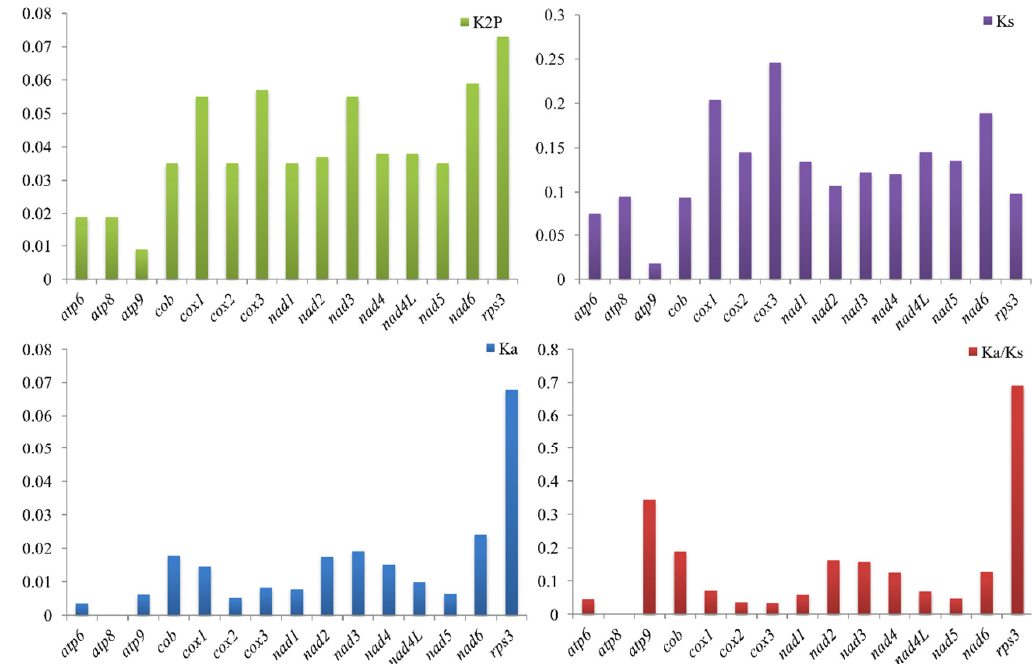
Figure 6. Genetic analysis of 15 protein coding genes conserved in two Rhizopogon mitogenomes. K2P — the Kimura − 2-parameter distance; Ka — the mean number of nonsynonymous substitutions per nonsynonymous site; Ks — the mean number of synonymous substitutions per synonymous site.